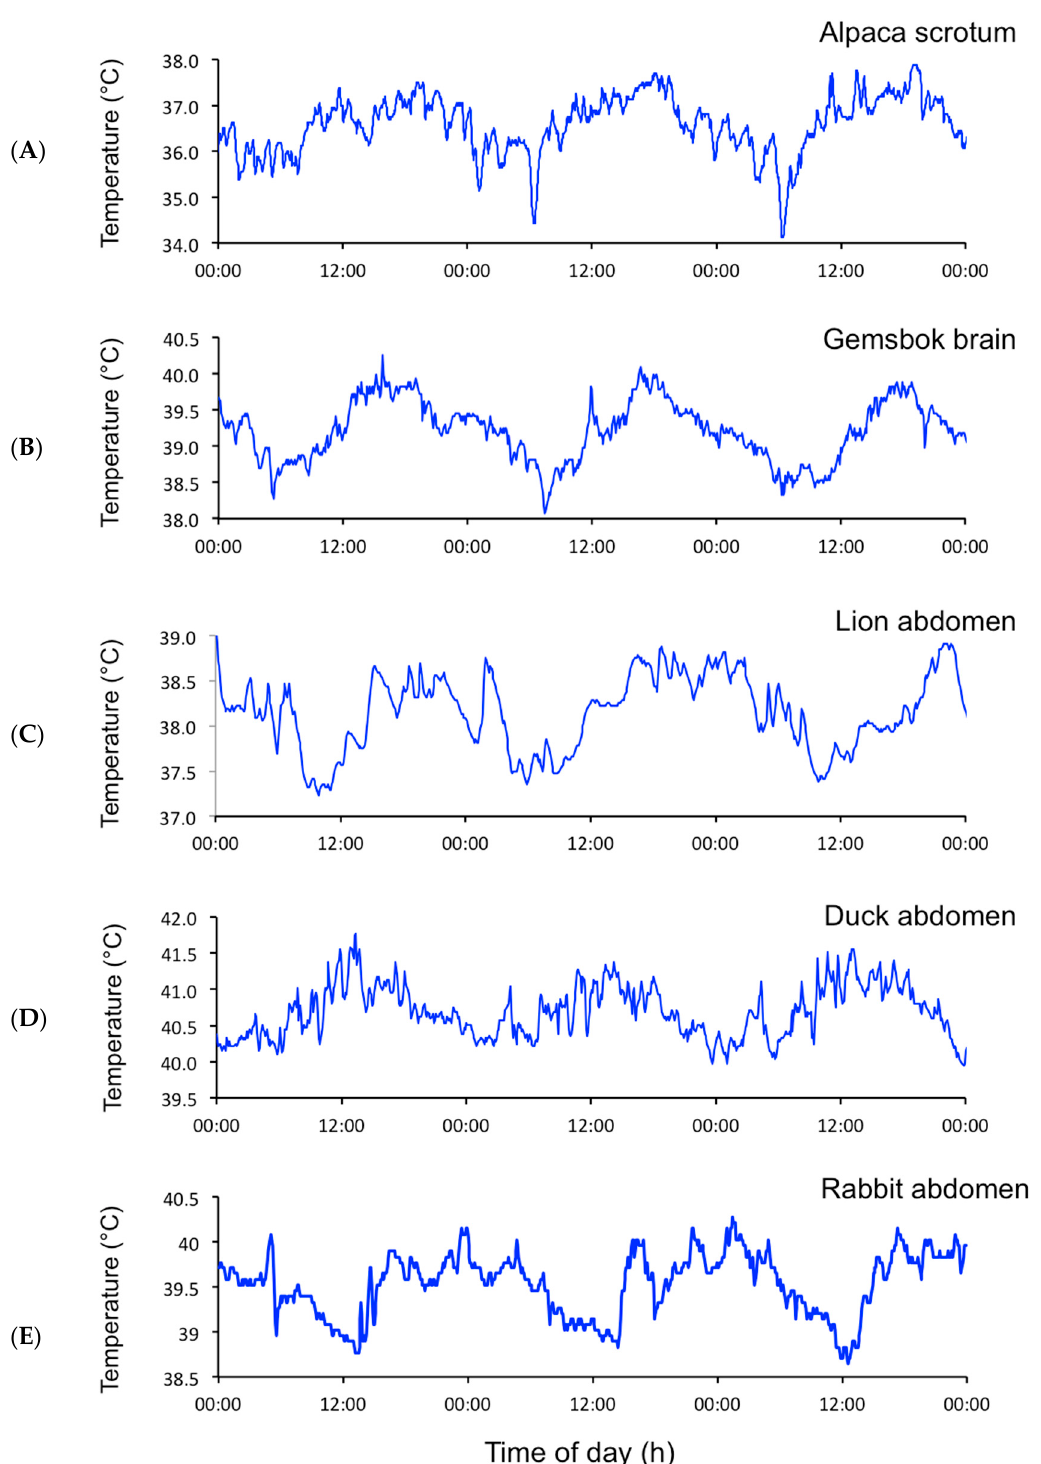
Figure 1. Three-day profiles of temperature in the scrotum of an alpaca (( A ): sampling rate = 1 min), the brain of a gemsbok (( B ): sampling rate = 5 min), the peritoneal cavity of a non-pregnant female lion (( C ): sampling rate = 1 min), a female duck (( D ): sampling rate = 5 min), and a pregnant female rabbit (( E ): sampling rate = 5 min). NB: the episodic ultradian events are superimposed on the strong circadian rhythms. All the animals were kept outdoors, either in outdoor paddocks with free access to food and water ( A , D ) or in their natural environment [12] ( B , C , E ). Lion data courtesy of Andrea Fuller [13].